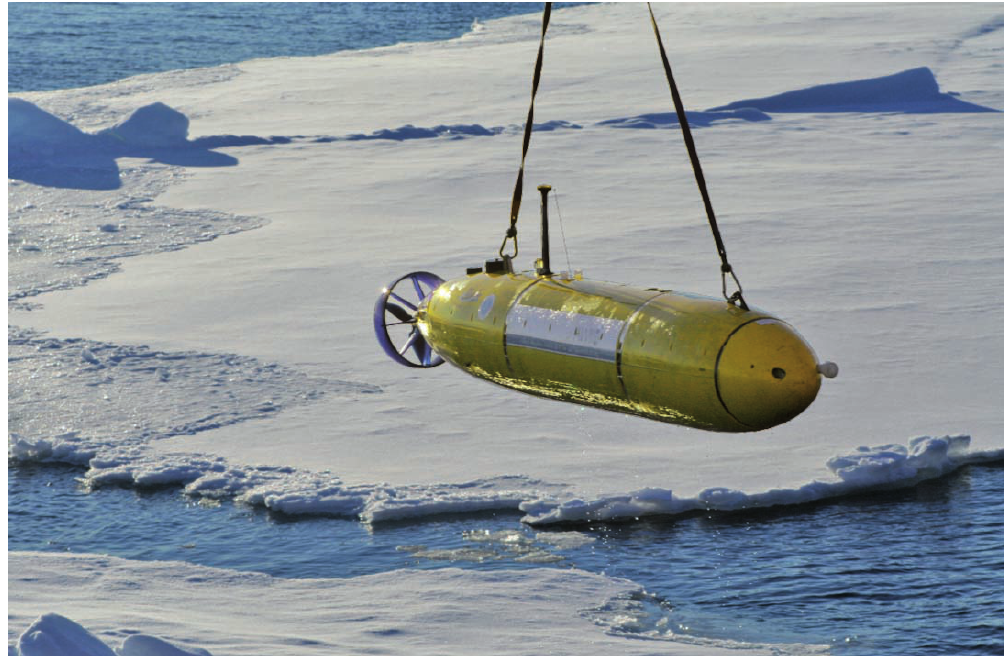
Figure 7. The Polar Autonomous Underwater Laboratory (PAUL), a Bluefin 21 AUV, equipped with physical and biogeochemical oceanographic sensors and a water sampler, observed biogeochemical processes at high resolution in the marginal ice zone of Fram Strait. Image Credit: Alfred Wegener Institute, Helmholtz Centre for Polar and Marine Research. Reproduced with